Question: What caption would you write for this figure?
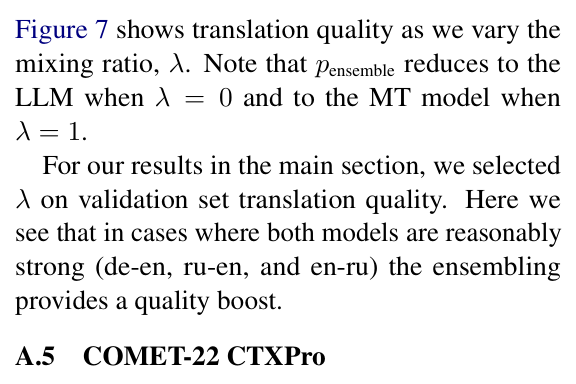
Answer: shows the COMET-22 scores correspond- ing to the document translation accuracy show in Table 5. The ensemble is always best on this data, then the MT, and then the LLM.